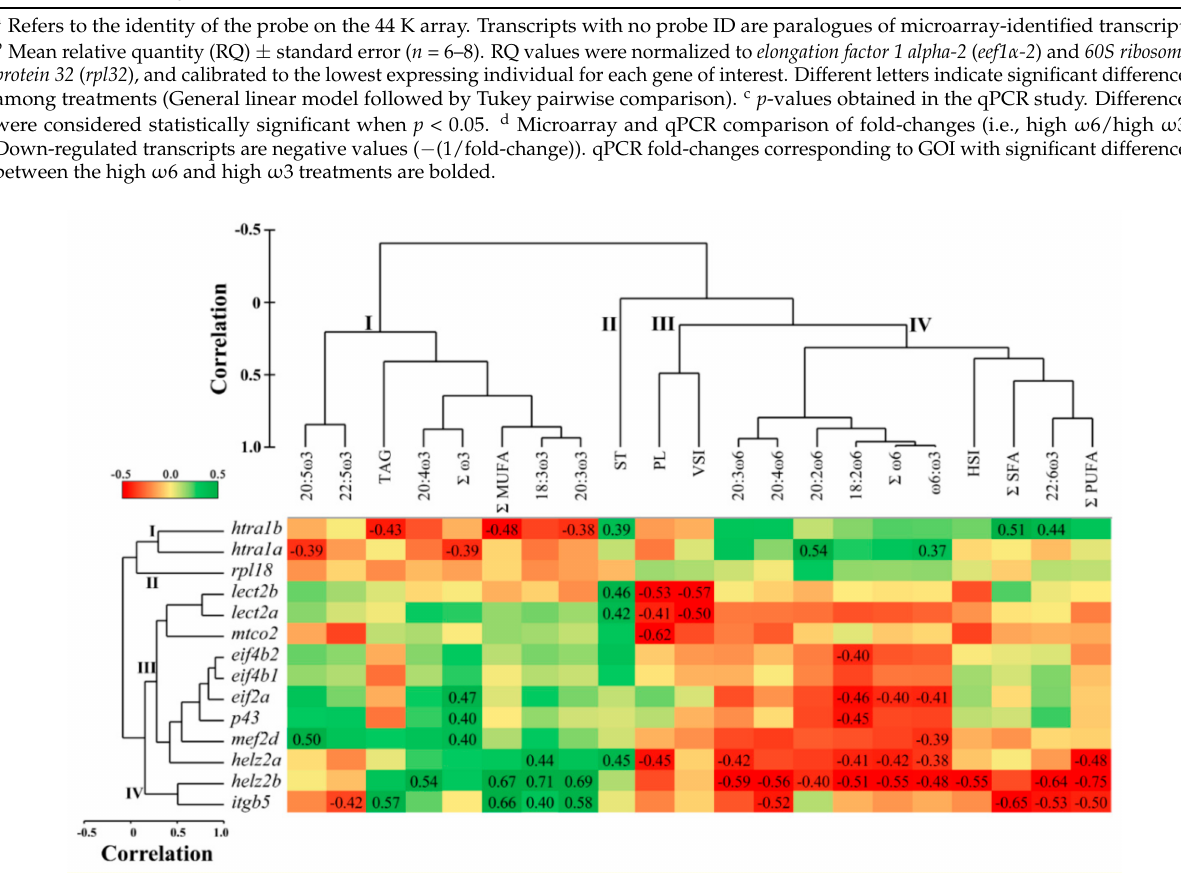
Figure 1. Pearson correlation matrix and hierarchical clustering of liver transcript expression (qPCR relative quantity values (RQ)), liver lipid composition, and somatic indices in Atlantic salmon fed diets with varying ω 6 to ω 3 fatty acid ratios. Correlation coefficients were described when correlations were statistically significant ( p < 0.05). Red signifies negative and green signifies positive relationships. Σ SFA, Σ MUFA, and Σ PUFA represents total saturated, monounsaturated and polyunsaturated fatty acids, respectively. 20:5 ω 3, 22:6 ω 3, and 20:4 ω 6 represent EPA, DHA, and ARA, respectively. TAG, ST and PL represent triacylglycerols, sterols, and phospholipids, respectively. HSI and VSI represent hepatosomatic and viscerosomatic indices,